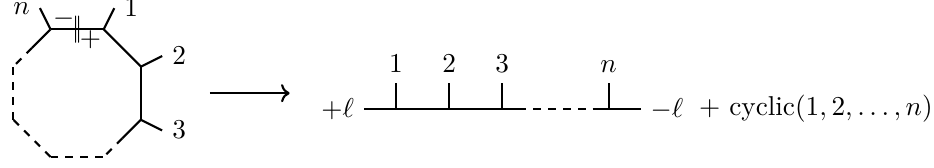
Figure 1 . Terms in the partial-fraction representation of n -point loop integrals in (2.35) can be interpreted as ( n +2) -point tree-level